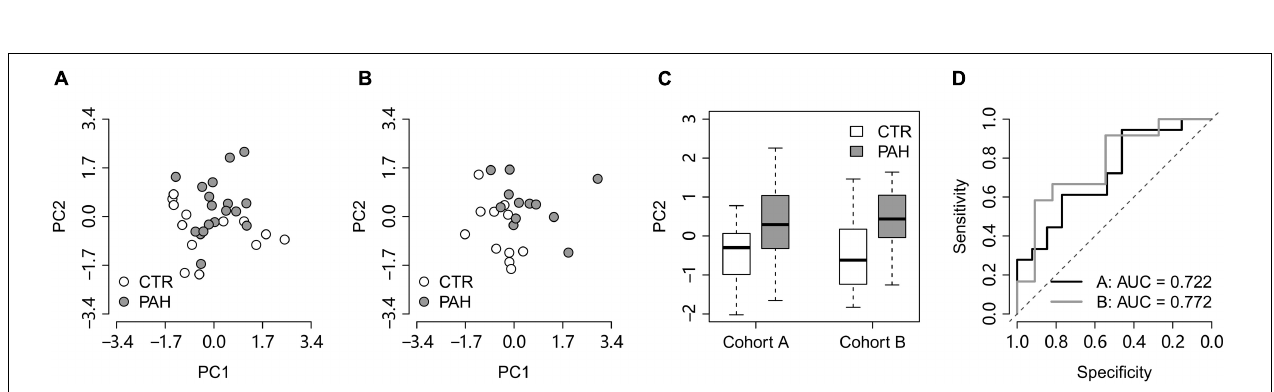
Frontiers in Cell and Developmental Biology |